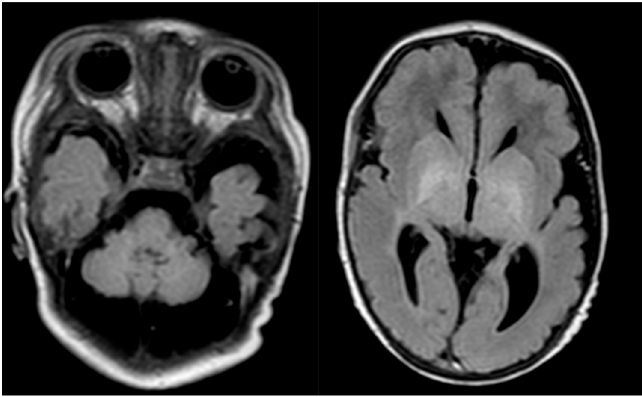
Figure 1. Proband’s brain MR. Cerebellar hypoplasia and dilated cerebellar fluid spaces.